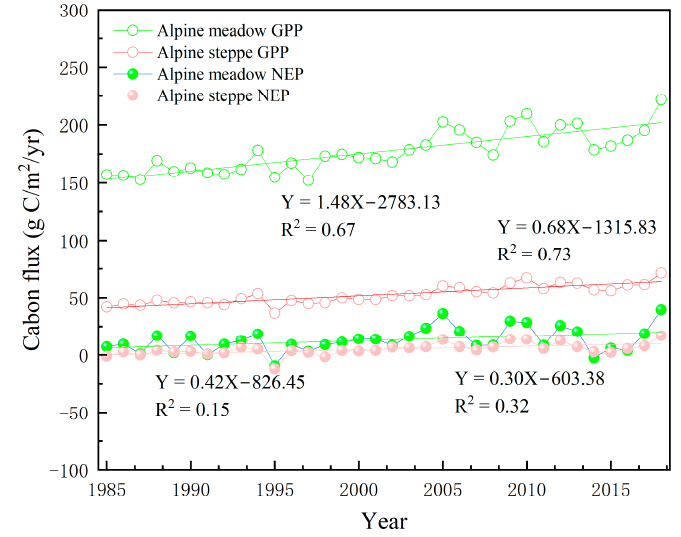
Figure 9. Alpine meadow and alpine steppe carbon fluxes in the TRSR.